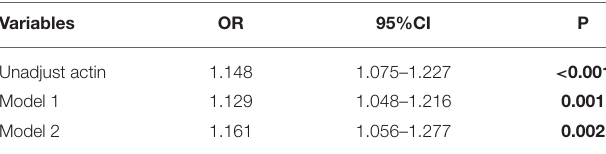
TABLE 3 | Logistic regression analysis for the association of actin with atherosclerotic